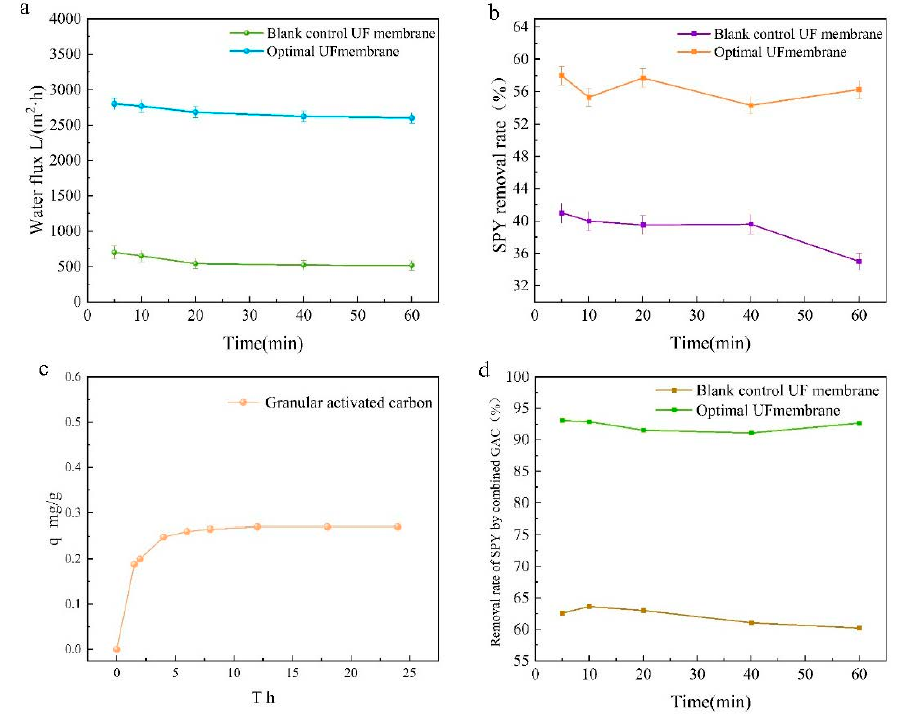
Figure 4. Performance test of CFGO-PVDF ultrafiltration membrane. ( a ) Pure water fluxes for the best ratio of CFGO-PVDF UF membrane and 0 wt% CFGO composite UF membrane; ( b ) removal performance of SPY from water with the best ratio of CFGO-PVDF UF membrane and 0 wt% CFGO composite UF membrane; ( c ) the kinetics of adsorption of sulfapyridine in water by activated carbon at room temperature (300 k); ( d ) the performance of CFGO-PVDF UF membrane and 0 wt% CFGO UF membrane in combination with AC for the removal of SPY in water.